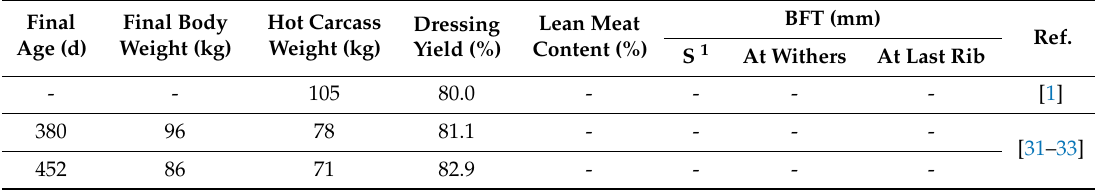
Table 3. Overview on body composition and carcass